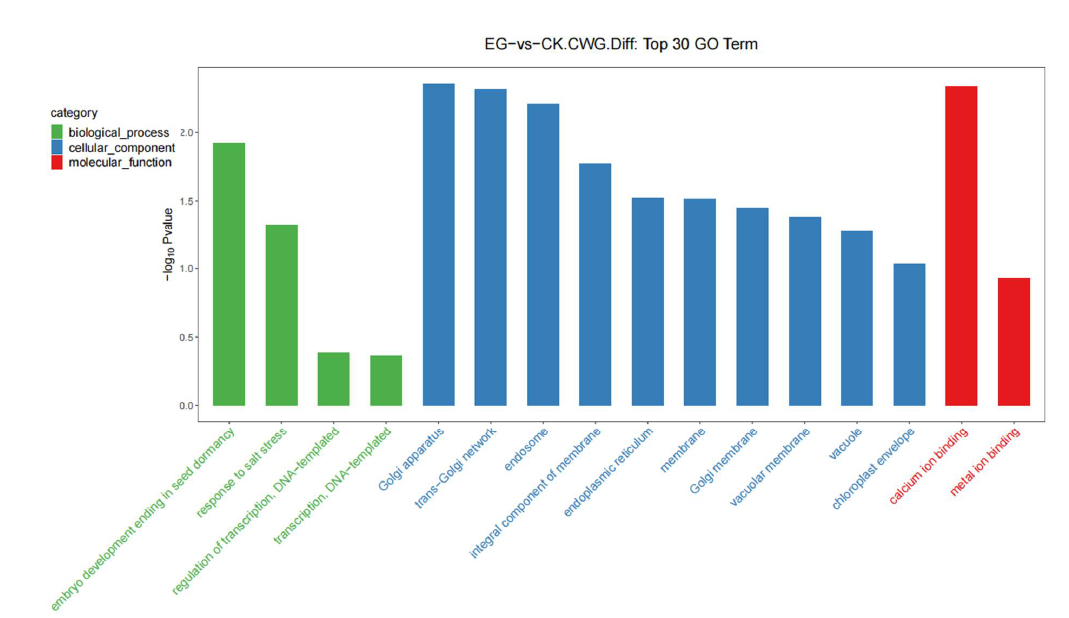
Figure 9. Bar chart of the top 30 GO functions of the genes where CG and CWG differential methy- lation sites are located. ( A ) The top 30 GO terms at the mCG sites; ( B ) the top 30 GO terms at the mCWG sites. The x coordinates are the name of the GO entry, and the y coordinates are-log10Pvalue. The green, blue and red colors represent biological process, cellular component, and molecular functions, respectively.